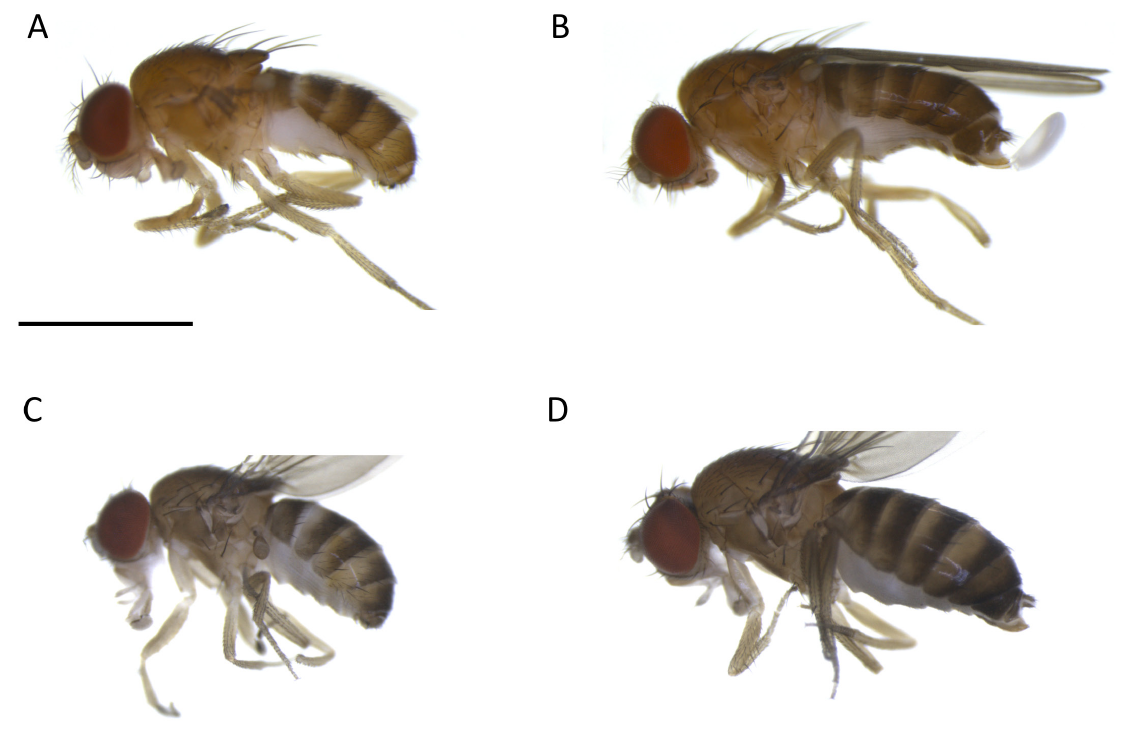
Fig. 8. Adult habitus. A – B . D. vulcana Graber, 1957 (MNHN). A . ♂. B . ♀. C – D . D. mylenae David & Yassin sp. nov. (MNHN). C . ♂. D . ♀. Scale bar = 1